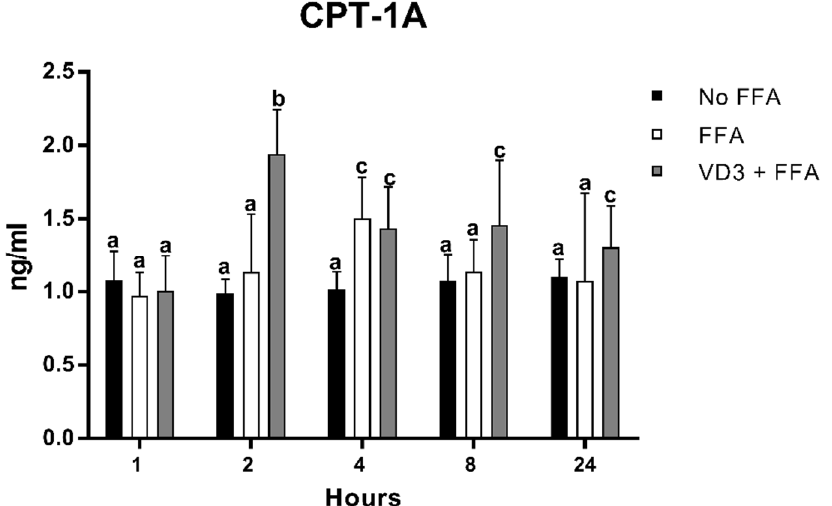
Figure 7. Effect of VD3 supplementation on PPAR- γ 1 protein levels. Data are reported as mean ± standard deviation. a,b,c Bar graphs with different letters are significantly different ( p ≤ 0.01). No FFA: no free fatty acids (control); FFA: free fatty acids (500 μ M); VD3: calcitriol (50 nM).